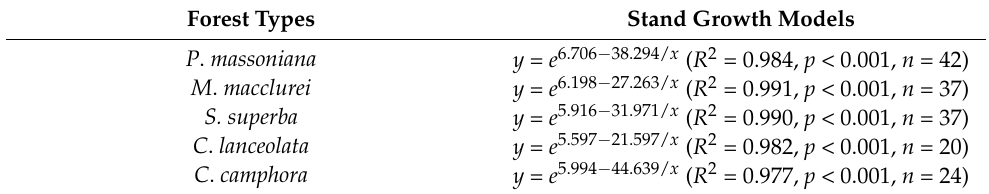
Table 1. Stand growth models for the Moshao forest farm, where y represents trunk biomass and x represents stand age, n represents how many trees have been used to fit the model of each species. Forest Types Stand Growth